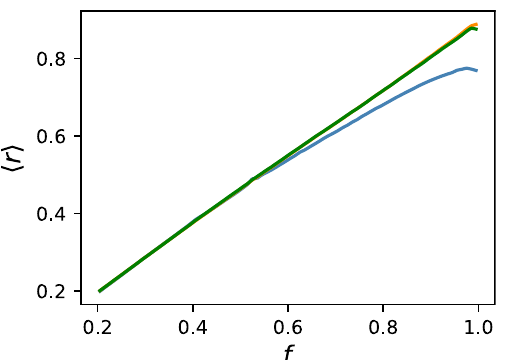
Fig 2. Average of the robustness measure r against fitness. The average was taken over all the samples in each bin. The blue line represents random sampling. The orange and green lines represent Evo50 and Evo90, respectively. GRNs obtained by ES were classified according to f into 100 bins, similar to random sampling. The slight decrease at the highest fitness for Evo90 was not caused by a statistical